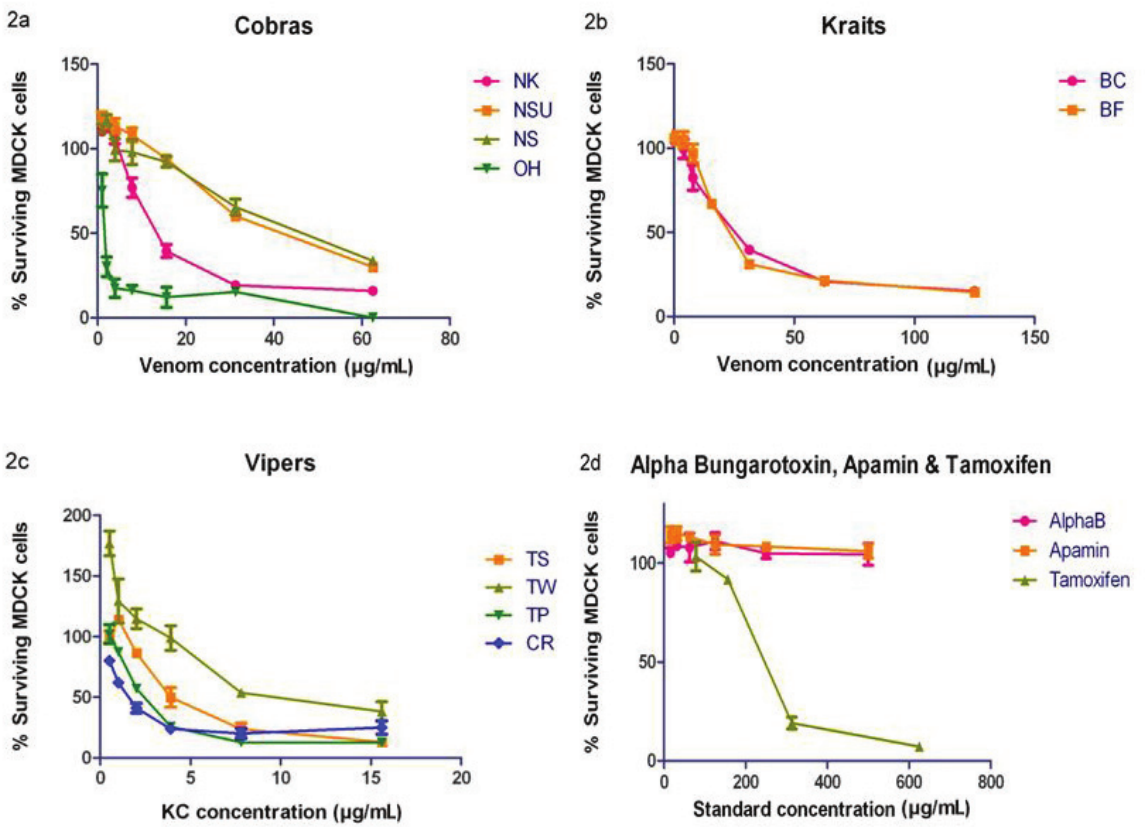
Figure 2. Cytotoxicity curves of snake venoms and standards in MDCK cells. For each venom sample (n = 3); experiments were repeated three times and the results are displayed as mean values. Points are the means and bars are the SD values.